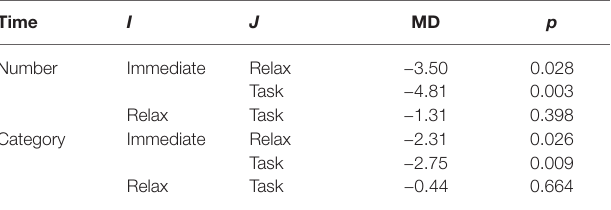
TABLE 1 | Post hoc multiple comparisons of ideas generated in last 10 min (Experiment